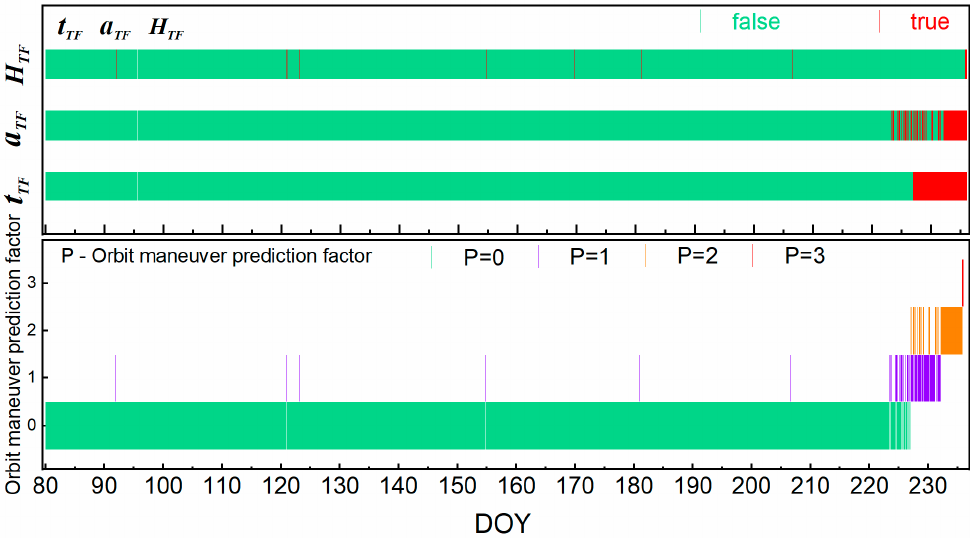
Figure 6. Orbit maneuver prediction factors for C07 satellite.